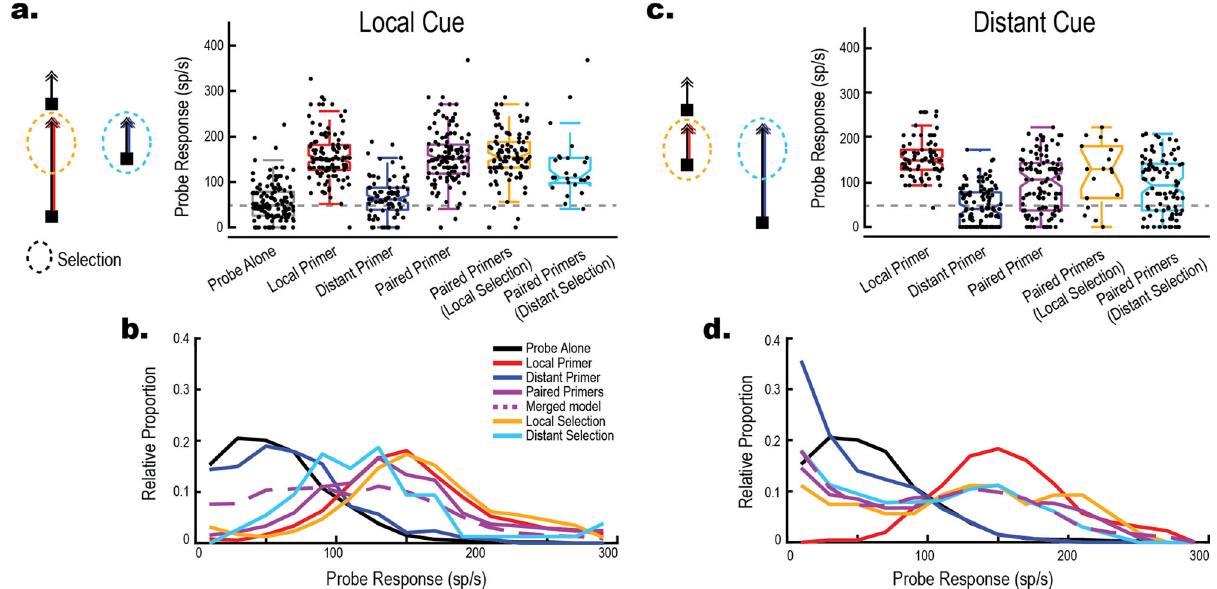
Fig. 3 A Cue for selection can modulate facilitation. a Stimulus pictograms and boxplots illustrating the neuronal response to the probe for trials where the cue was matched to the Probe location (Local). Total 122 Matched trials across 15 dragon fl ies, control data as from previous fi gures reproduced for comparison. Grey dashed line indicates the Probe Alone mean. In trials where the Cue is successful (Local Selection, gold) we observe facilitation. However, in trials where the Cue is ignored (Distant Selection, cyan) we observe suppression of the local path. b Frequency polygons showing Probe response distributions for the conditions in A. c Trials where the Cue was unmatched to the Probe location (Distant). Total 111 unmatched trials across 15 dragon fl ies, control data as from previous fi gures reproduced for comparison. Grey dashed line indicates the Probe Alone mean (Distribution in A). Unmatched trials reveal Paired Primer responses similar to the broad distribution of the Merged Model (Dashed purple line), regardless of whether Paired Primers were categorized as Local Selection (gold) or Distant Selection (cyan). d Frequency polygons showing Probe response distribution for the conditions in c